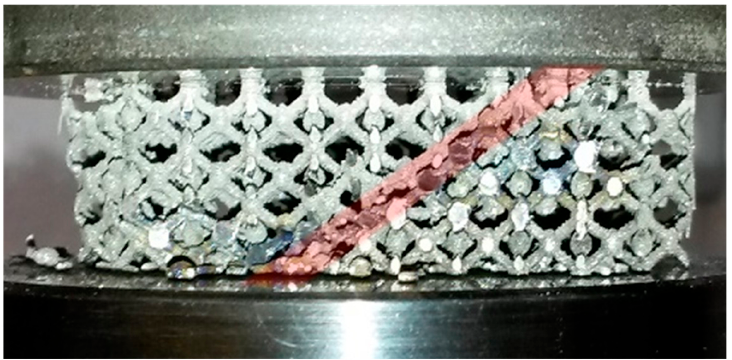
Figure 21. Actual deformation in BCC during compression testing. Areas of diagonal shear collapse have been highlighted faintly in red.